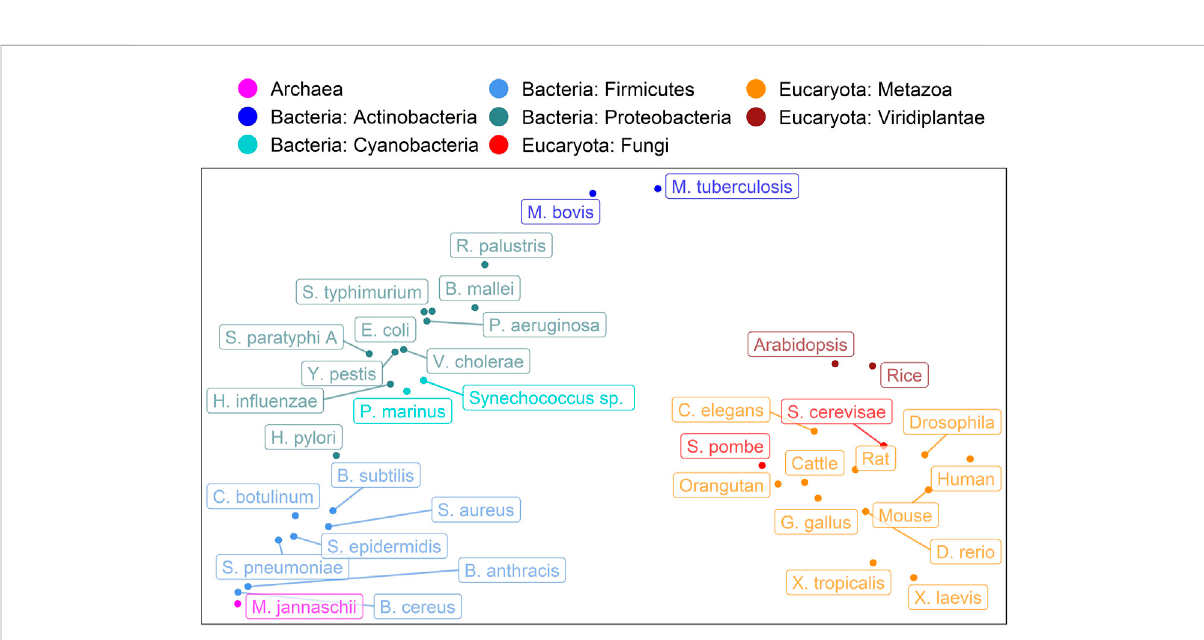
FIGURE 6 Evolution captured by spectrum of predicted CheZOD scores. Data: SETH predictions for proteins from 37 organisms taken from Swiss-Prot (The UniProt Consortium et al., 2021). The plot shows the PCA (Wold et al., 1987) of the binned spectrum of predicted CheZOD scores (8 bins, meaning 8-dimensional vectors; each vector describes one organism). The colors indicate the super-kingdoms (Eukaryota: reds, Bacteria: blues, Archaea: violet) as well as the Phyla for the Bacteria and the Kingdoms for the Eukaryotes, as given in UniProt (The UniProt Consortium et al., 2021). The organism names were shortened (for complete organism names see Supplementary Table